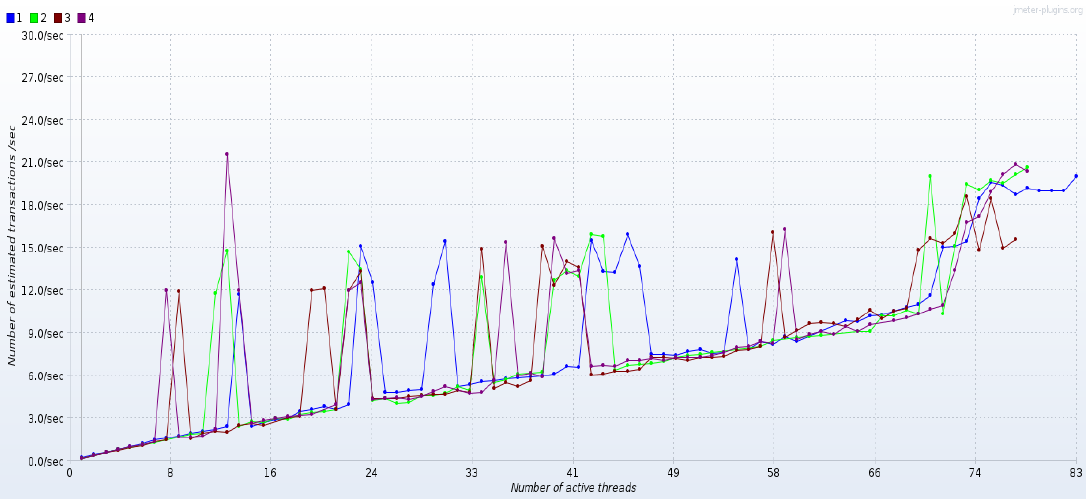
Figure 12. Overall results of the throughput in the local machine.